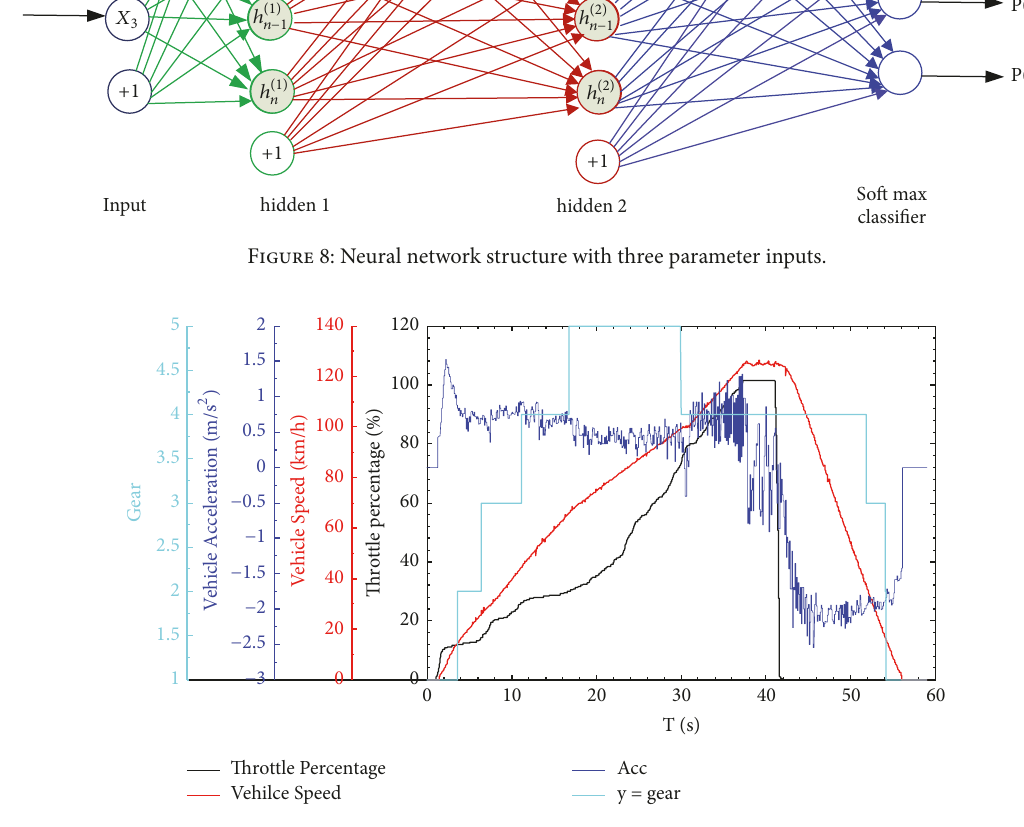
Figure 9: Road test